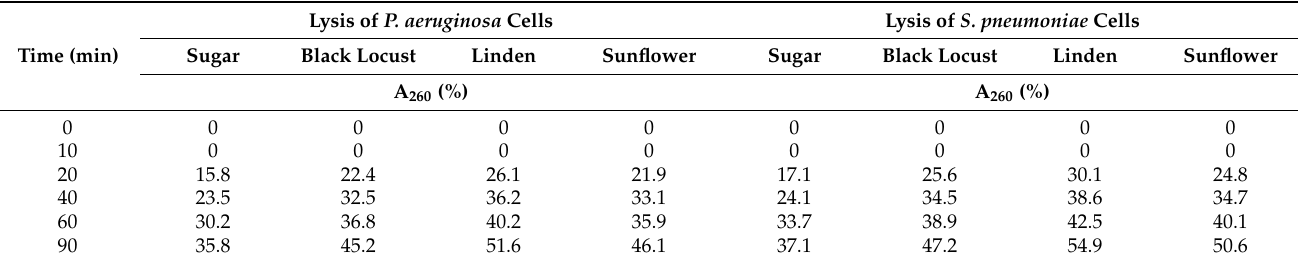
Table 5. Kinetics of 260-nm absorbing material release from P. aeruginosa and S. pneumoniae treated with 60% ( w/w ) sugar and honey